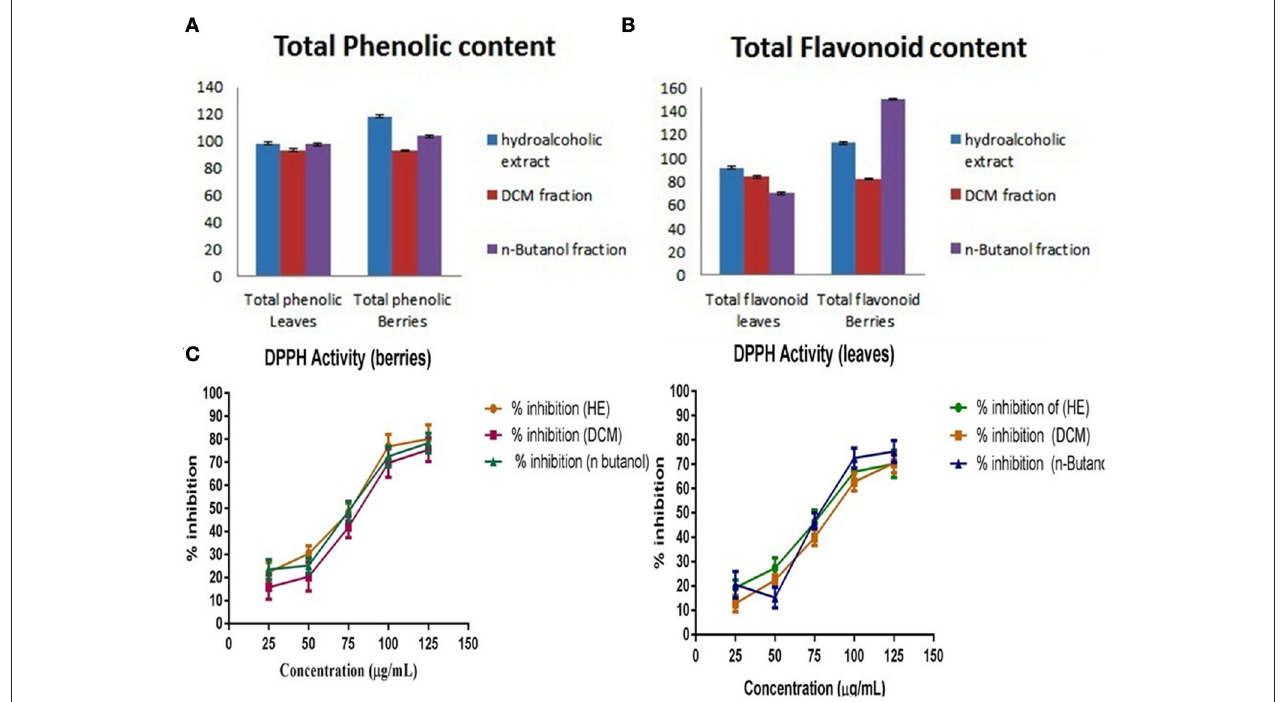
FIGURE 5 | (A) Total phenolic content, (B) Total flavonoidal contents, and (C) Total antioxidant activity of S. nigrum (leaves and berries) mother extracts and its